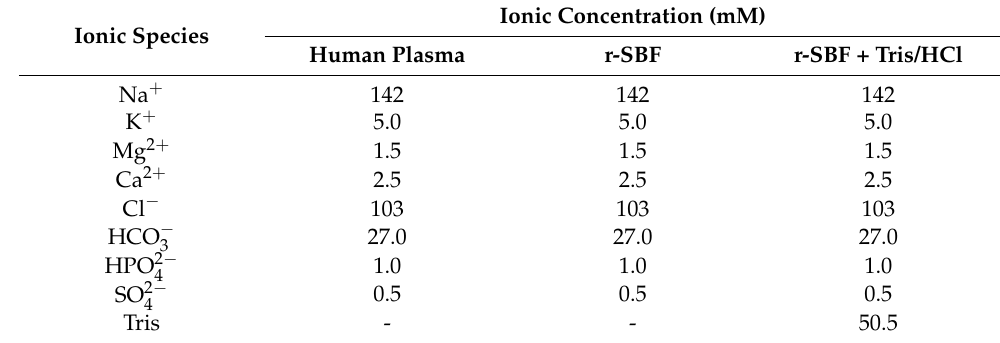
Table 2. Concentrations of the corrosion media components as compared to the human plasma.